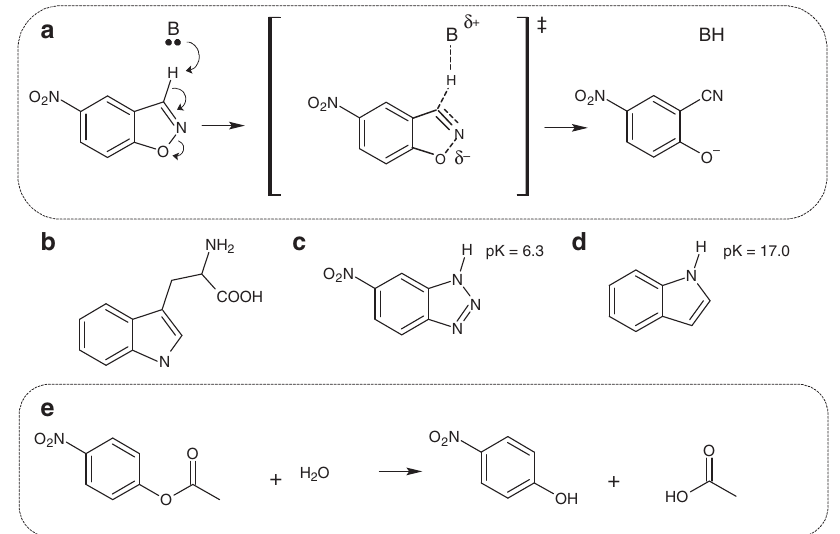
Figure 2 | Reactions and compounds studied in this work. ( a ) The Kemp elimination of 5-nitrobenzioxazole (5-nitro-benzo[d]isoxazole). A schematic transition state structure is shown here; ( b ) tryptophan; ( c ) 5(6)-nitrobenzotriazole (a transition-sate analogue) and ( d ) indole (the tryptophan side chain). Finally, ( e ) the hydrolysis of p -nitrophenyl acetate is also shown